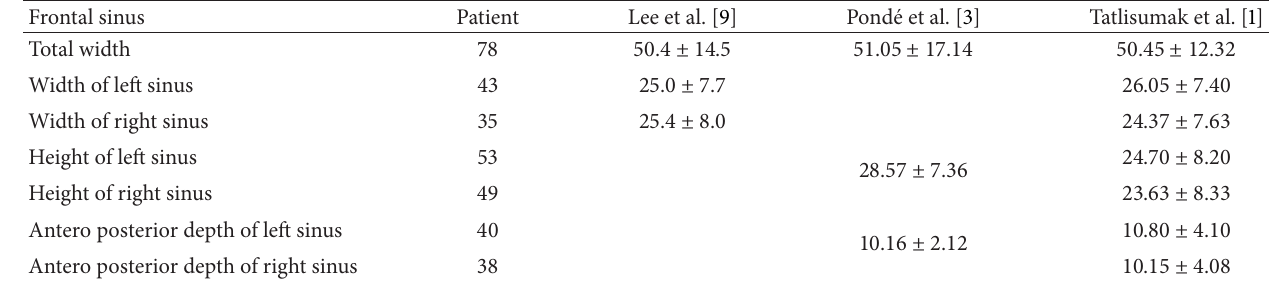
Table 1: Linear measurements (mm) of frontal sinus.